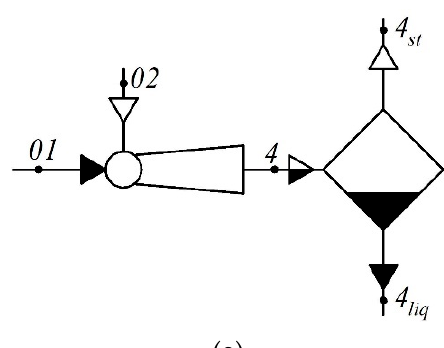
Figure 4. ( a ) “LVE + separator” system diagram and ( b ) scheme of exergy transformations: 𝐸 (cid:3005) + 𝐸 (cid:3013) —destruction and losses of exergy.